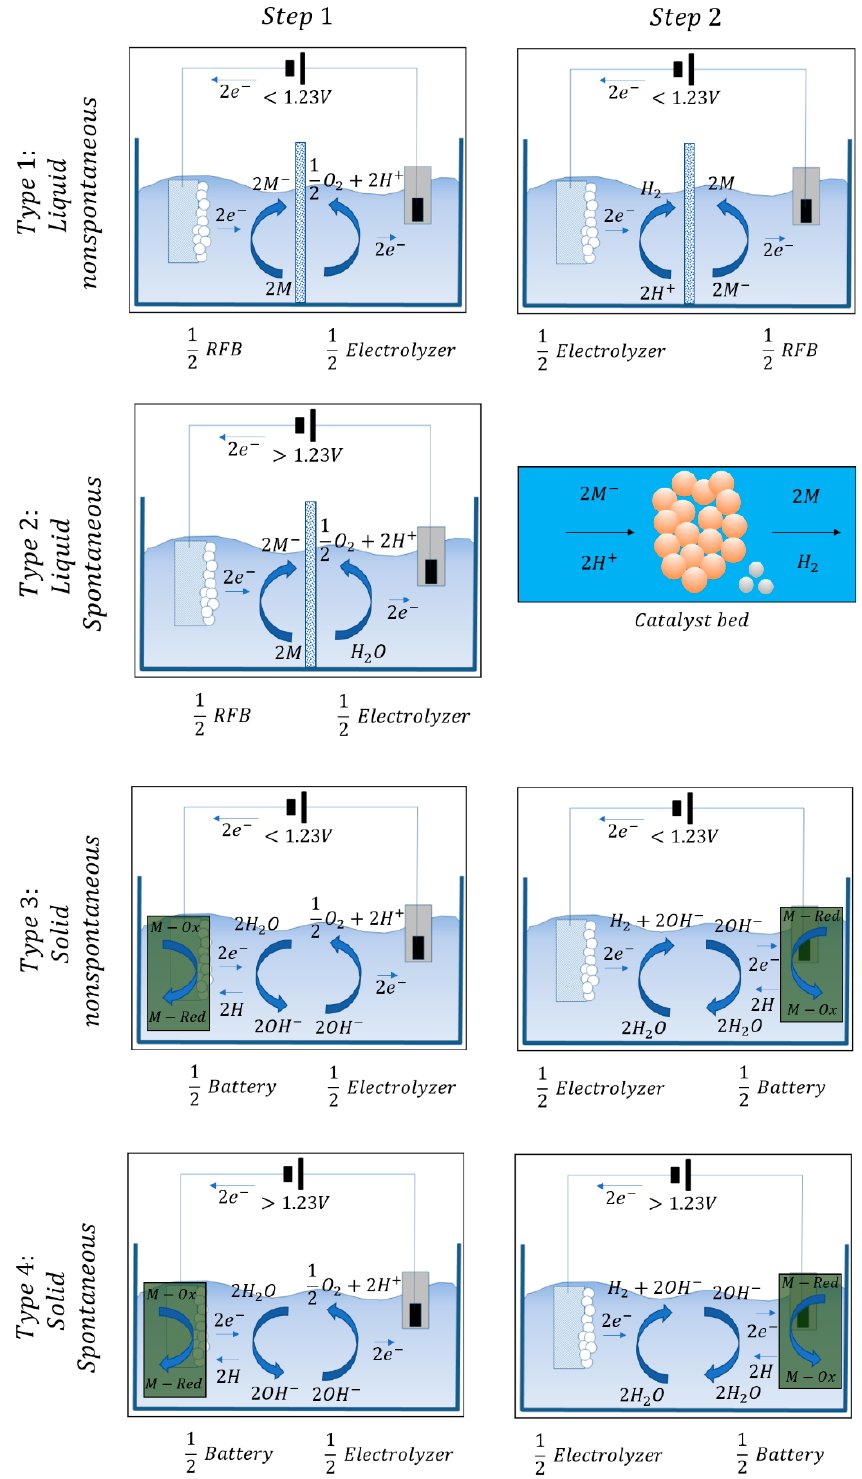
Figure 9. Different decoupled water splitting systems.